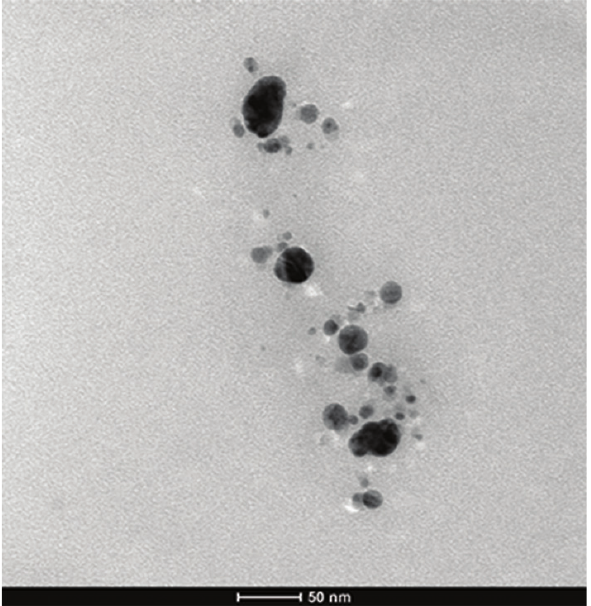
A Figure 6: TGA analysis of synthesized FeNP